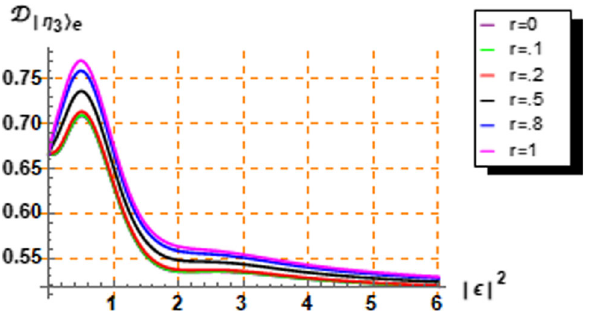
Fig. 17 This figure is the reproduction of the portion of Fig. 16d cor- responding to the range of values of | (cid:11) | 2 between 0 and